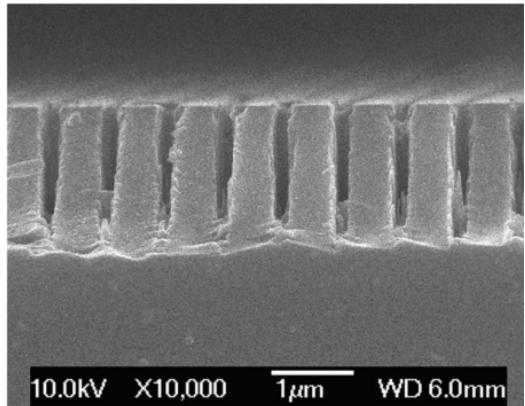
Figure 30. SEM image of the manufactured grating.